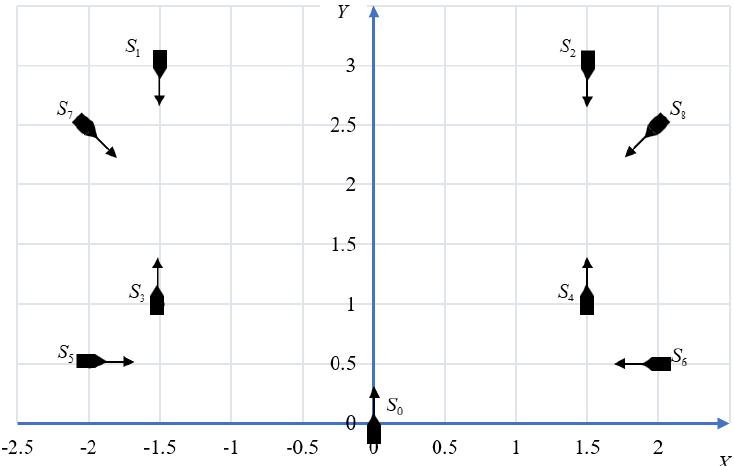
Figure 10. Ship encounter situation map. Table 3. Ship motion parameters.